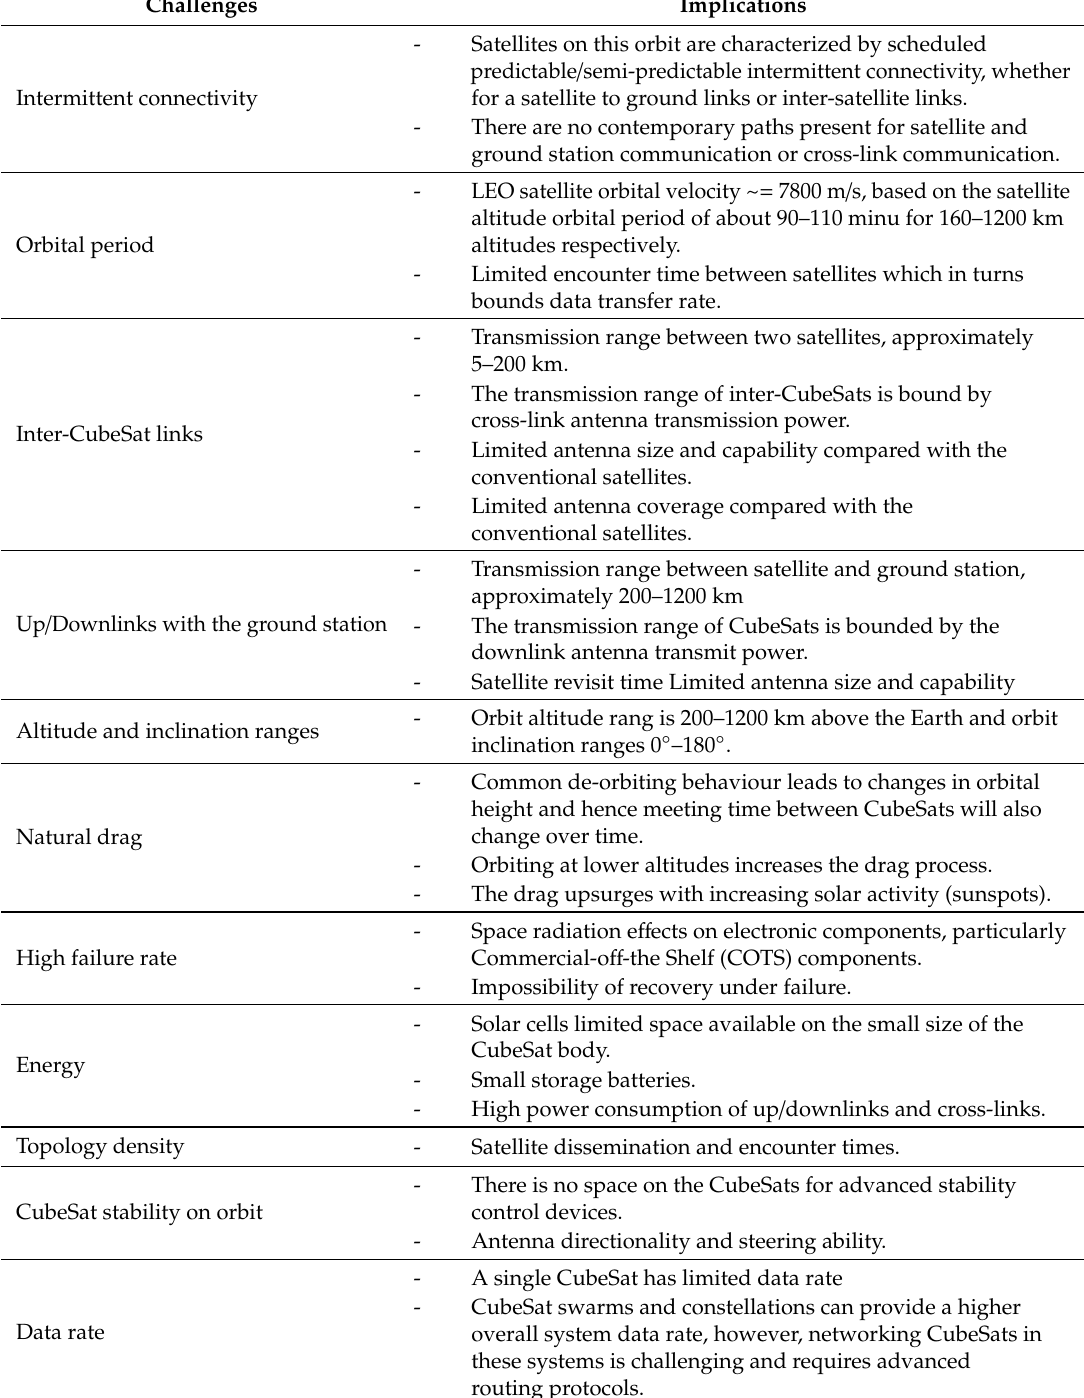
Table 1. Operating conditions of CubeSats on Low Earth Orbit (LEO), challenges, and